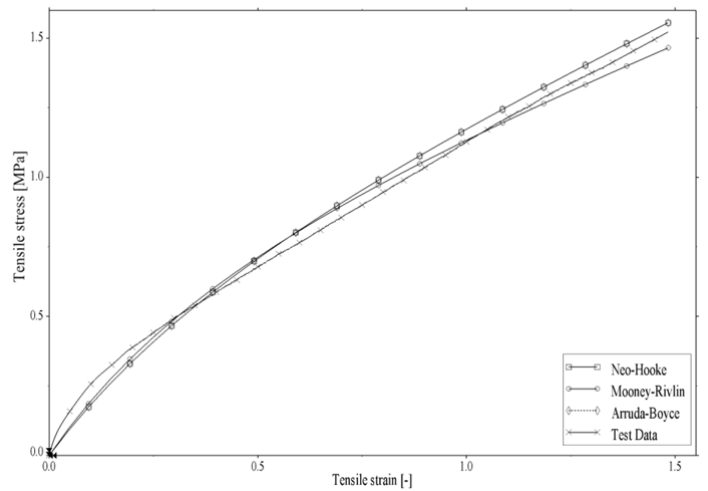
Fig. 6 Experimental data and material laws for Sikasil ® SG-500 under